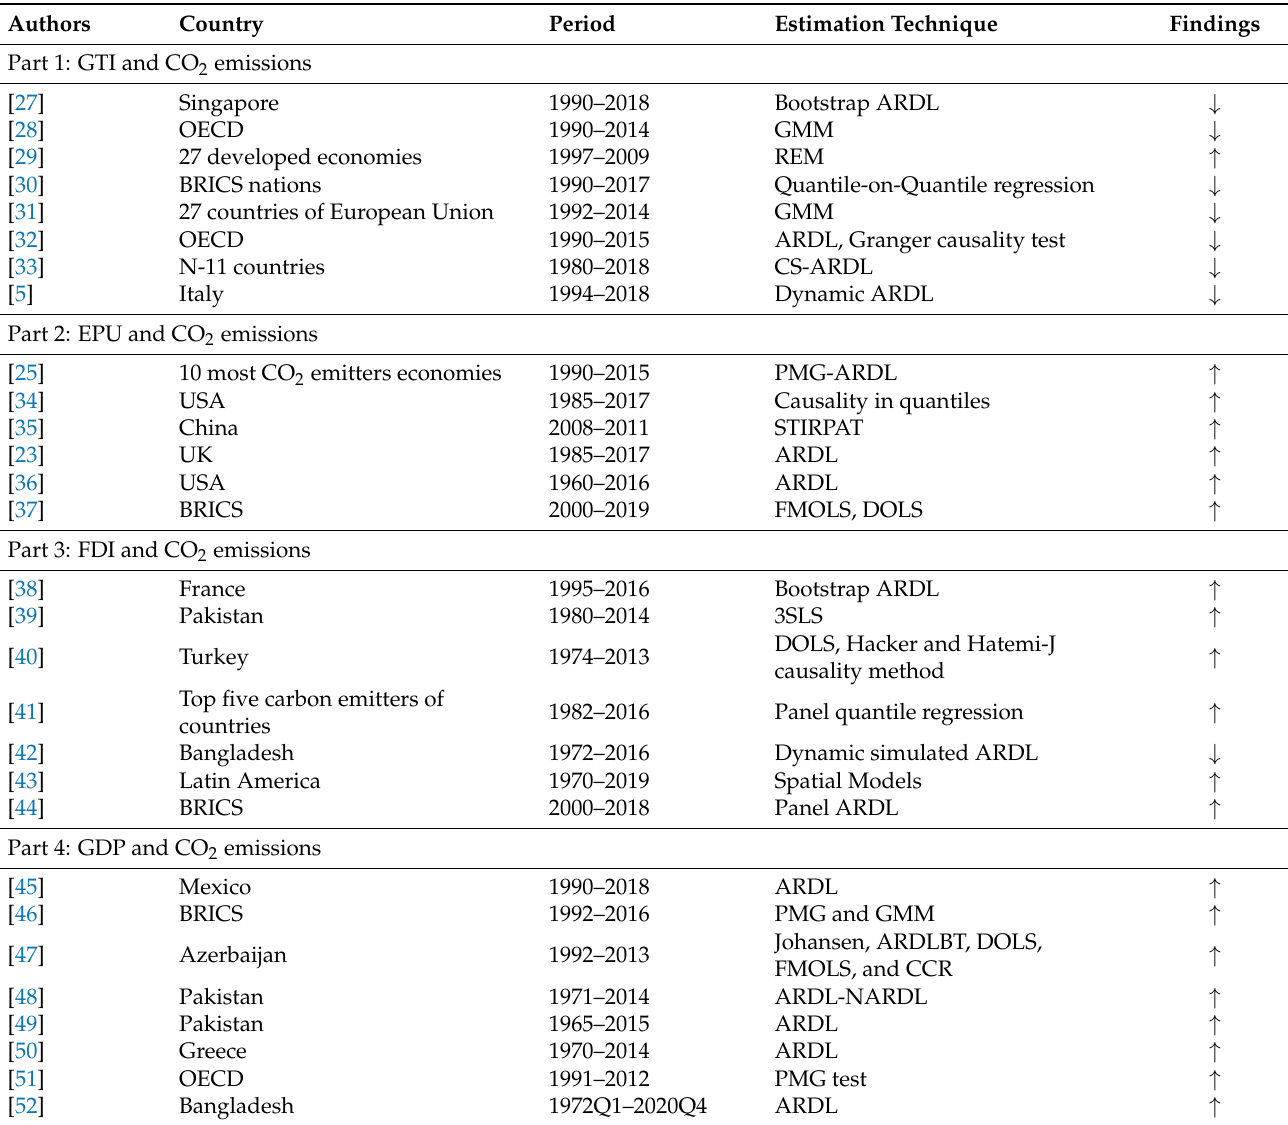
Table 1. Literature